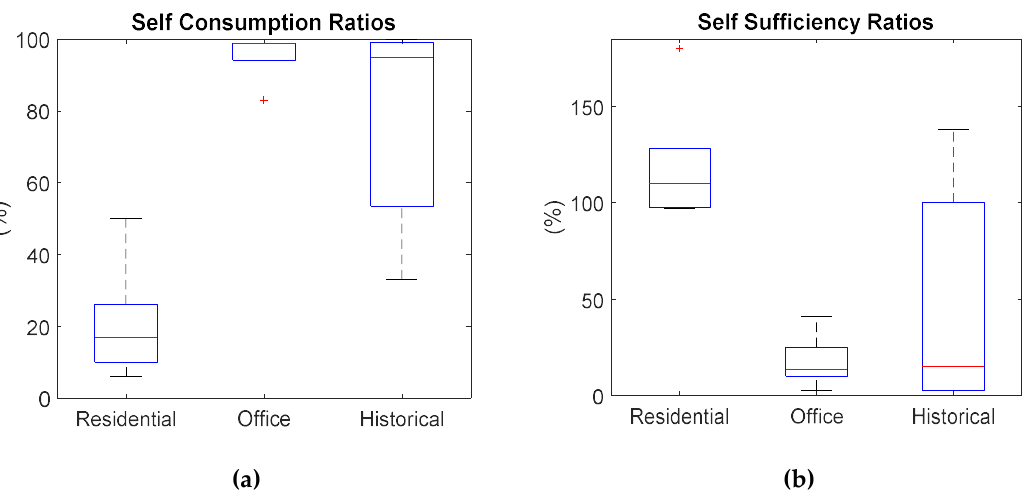
Figure 5. Self-Consumption ( a ) and self-sufficiency ( b ) ratios in percentages for three types of buildings.